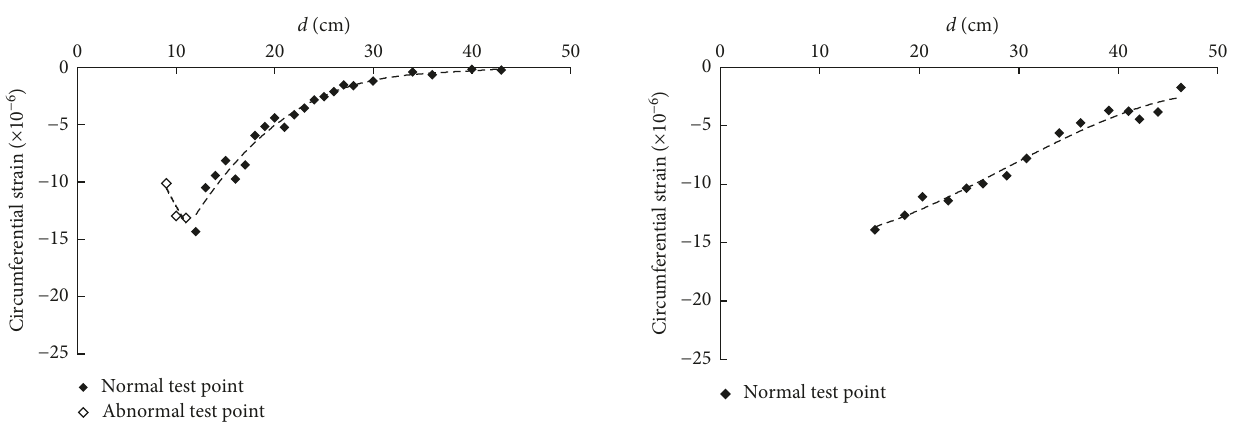
Figure 11: Top surface circumferential strain of the CSM model after removing the abnormal points.